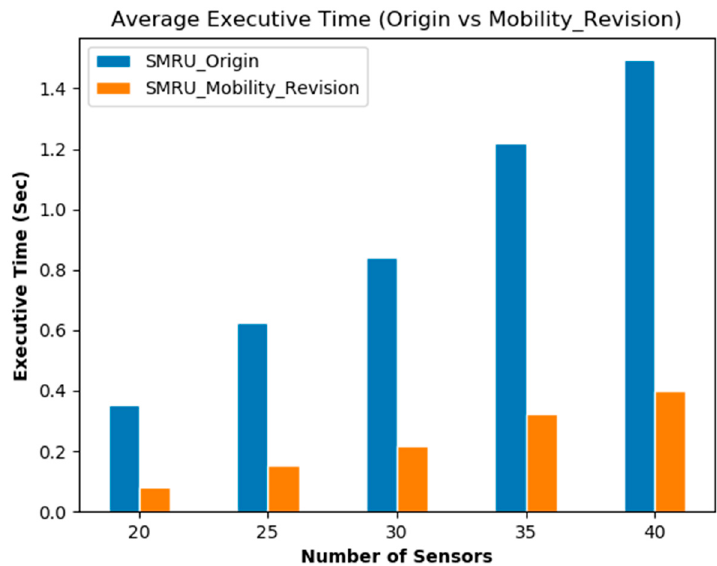
Figure 10. Comparison of the execution time of charger deployment and modified deployment using SMRU.